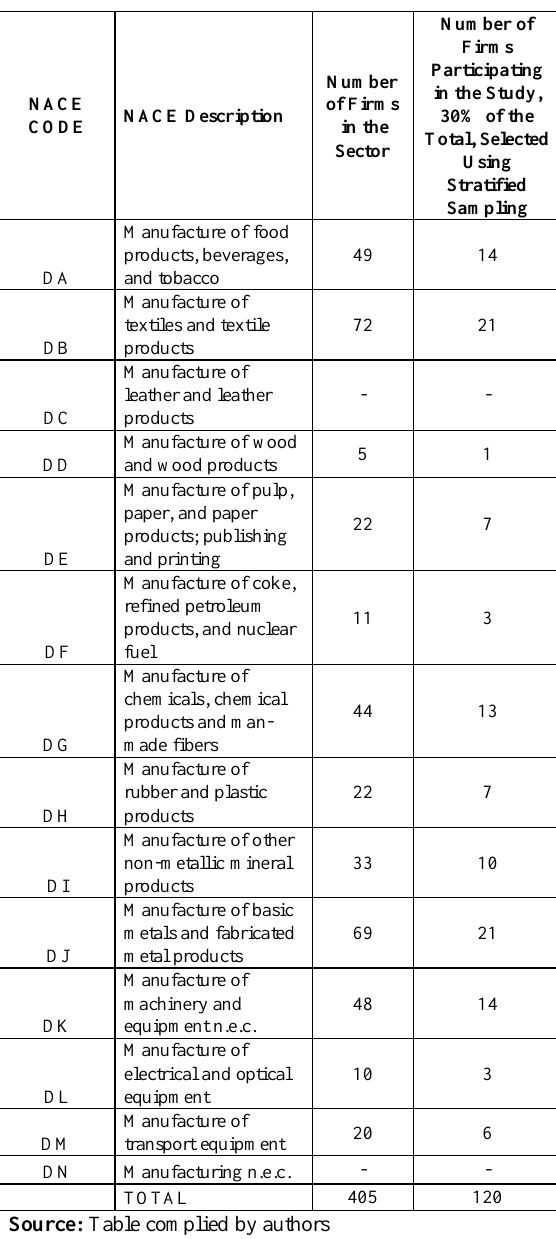
Table 1: The Number and Distribution of Firms to Sectors using the 31-item NACE